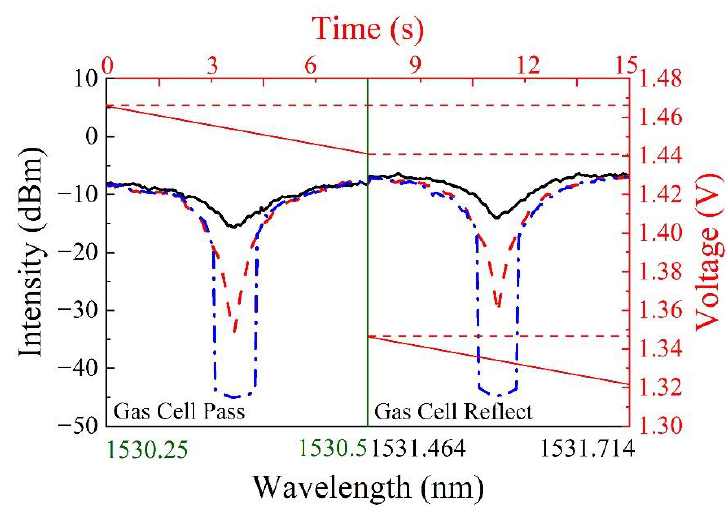
Figure 6. The laser output spectra by using voltage gradient method.